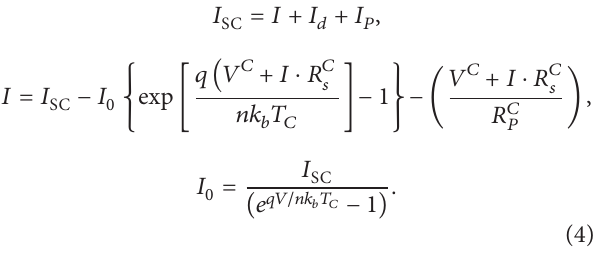
Figure 6: A simple GA flow